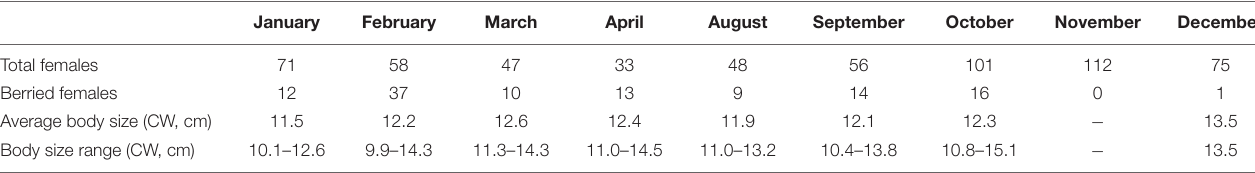
FIGURE 6 | (A) Percentages of Calappa philargius berried females ( N = 112) by month and egg color, and (B) percentages of berried females (irrespective of egg coloration) by month from January to December 2019. No samples in May–July 2019. Numbers above the bars referred to sample sizes ( Table 3 ). TABLE 3 | Body size variation of Calappa philargius berried females, sampled from January to December 2019 by trawl vessels in the southern Taiwan Strait,